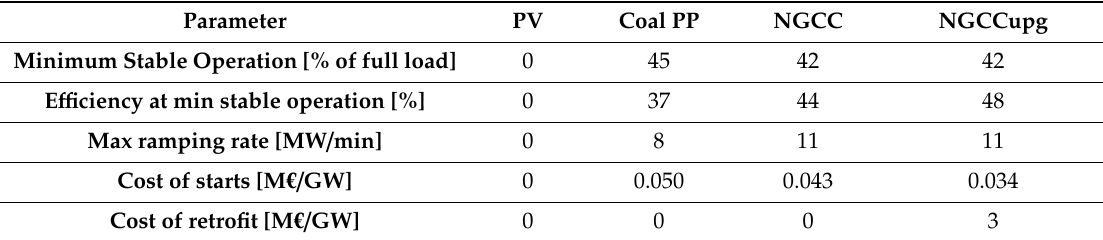
Table 3. Additional techno-economic assumptions for the case